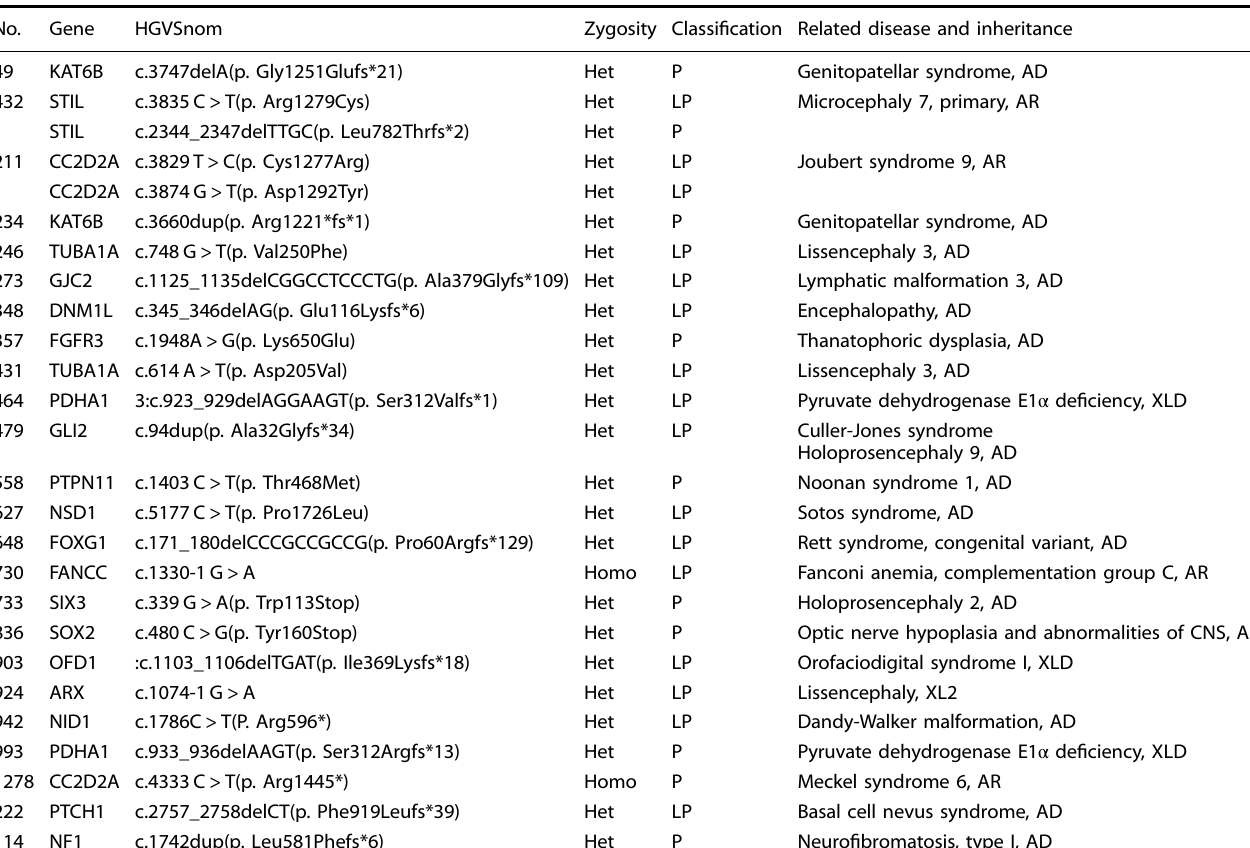
Table 2. Diagnostic SNVs identi fi ed by